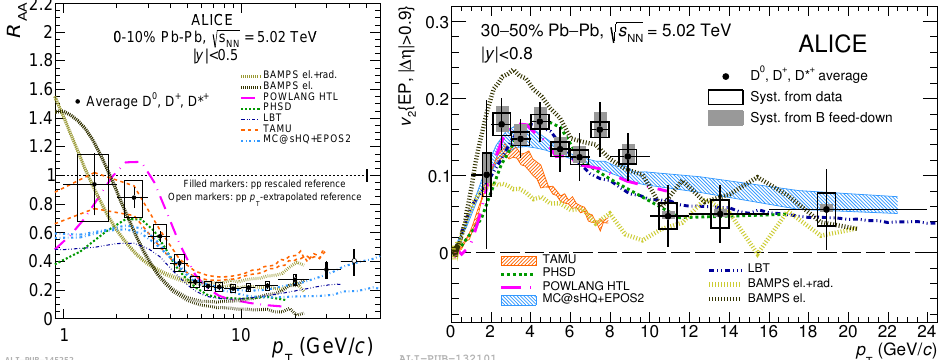
Figure 5. ( Left ) Average nuclear modification factor R AA of D 0 , D + and D ∗ + mesons in central Pb-Pb √ s NN = 5.02 TeV [23], compared to transport model calculations [24–28]. ( Right ) collisions at